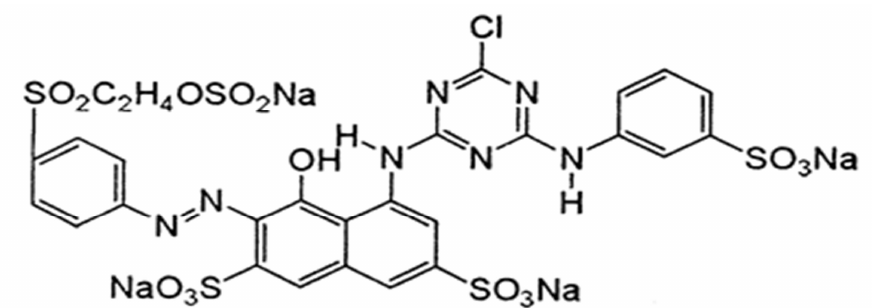
Figure 1. The chemical structure of Reactive Red 198